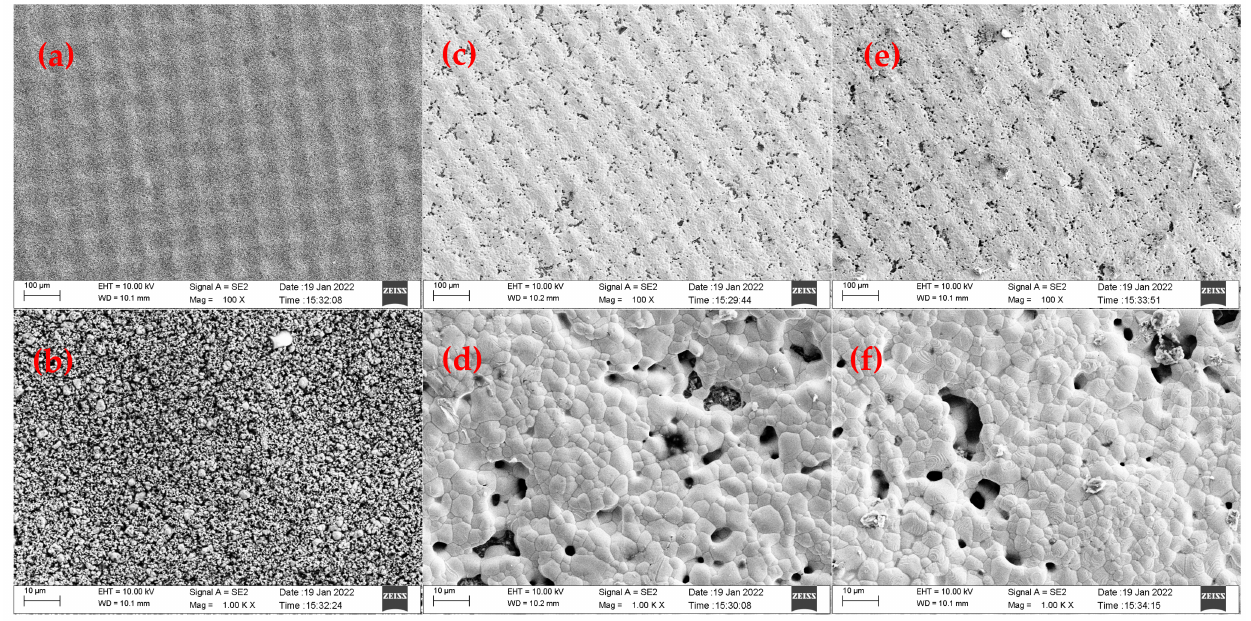
Figure 11. ( a , b ) Different magnifications of SEM images of sensor after screen printing, ( c , d ) different magnifications of SEM images of sensor after production, ( e , f ) different magnifications of SEM images of sensor after third